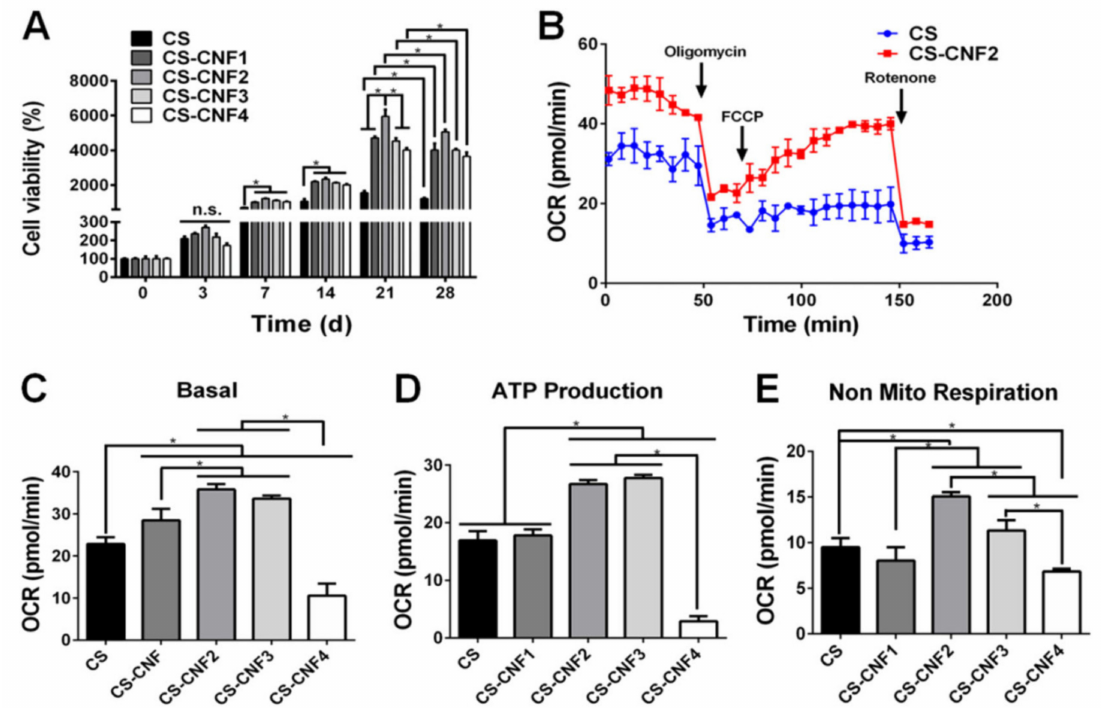
Figure 9. The cell growth ability and oxygen metabolism of neural stem cells (NSCs) in different CS-CNF nanofiber hydrogels contents of CNFs (0.06, 0.09, 0.12, and 0.15 wt%) ( A ) The measuring cell viability and proliferation measurement by the CCK-8 assay. ( B ) The oxygen metabolism of the cells inside hydrogels was evaluated via the oxygen consumption rate (OCR) marker and oligomycin, FCCP, and rotenone used as an inhibitor. ( C – E ) Evaluation of the OCR parameters for NSCs in different self-healing hydrogels indicated Basal OCR values, ATP production, and nonmitochondrial oxygen consumption increased in CS-CNF in computation CS and highest concentration CNF4(0.15 wt%). Reused permission with from [93] Copyright © 2021 NPG Asia